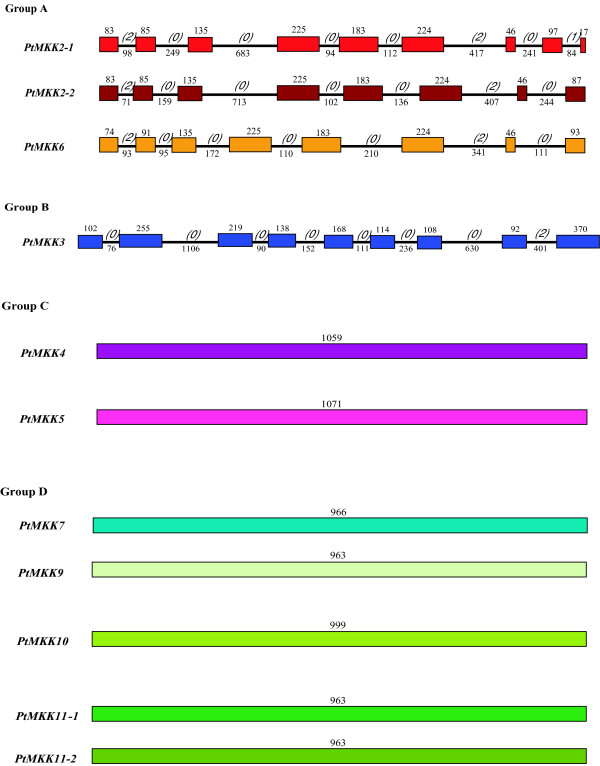
Intron and exon organization of poplar MAPKK genes (PtMKKs). Introns and exons are represented by black lines and colored boxes respectively. The length in base pairs of each intron and exon is also indicated. Numbers between brackets correspond to the intron phase. PtMKKs have been grouped according to phylogenetic classification [39].